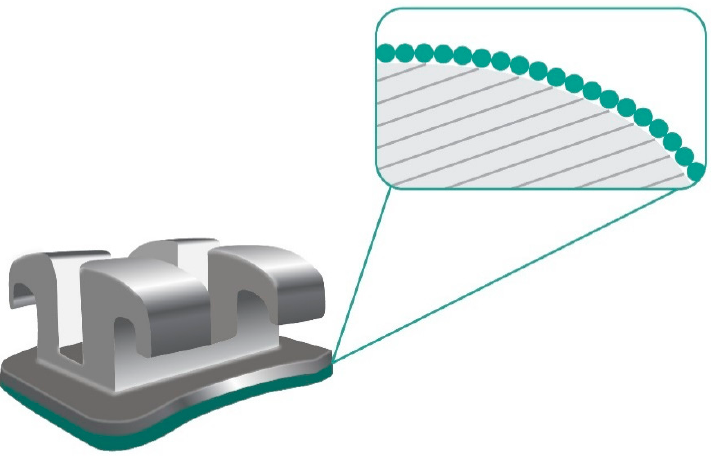
Figure 4. Orthodontic bracket covered by a nano-sized